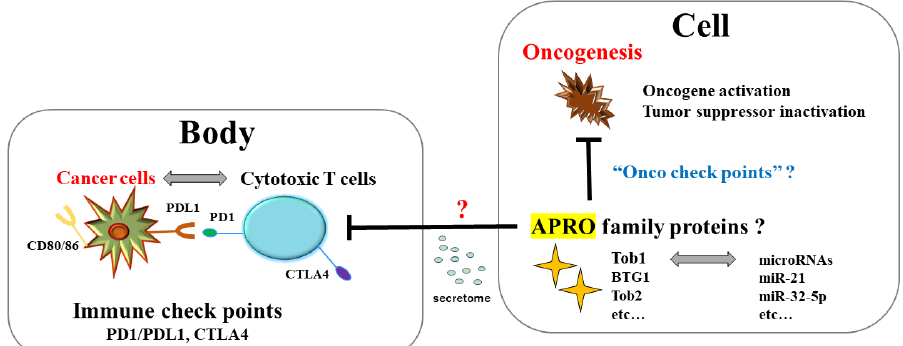
Figure 3. The relationship between tumor suppressor APRO family proteins and oncogenesis in a cell seems to look like the relationship between cytotoxic T cells and cancer cells in a body. It could be hypothesized that the former might be regulated by “Onco check points” with microRNAs for targeting APRO family proteins, whereas the latter is regulated by “immune checkpoints” molecules such as PD-1/PD-L1 and CTLA4. Cells expressing Tob1 might be able to regulate the cytotoxic T cells infiltrating to the adjacent places of Tob1 positive epithelial cells possibly via the paracrine signaling with secretomes. CTLA4: cytotoxic T-lymphocyte-associated protein 4; Onco: oncogenesis; ?: uncertainty Note. Adapted from “Roles of gut dysbiosis, anti-proliferative proteins, and post-transcriptional regulation in carcinogenesis,” by Sawamura H, Taniguchi K, Ikeda Y, Tsuji A, Kitagishi Y, Matsuda S. J Transl Genet Genom. 2022;6:157–68 ( http://dx.doi. org/10.20517/jtgg.2021.57). CC